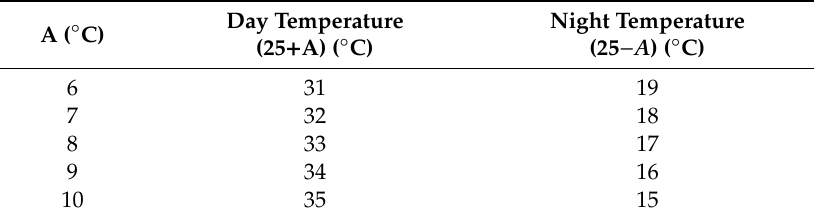
Table 4. Day and night temperatures for di ff erent values of A and a T m of 25 ◦ C.